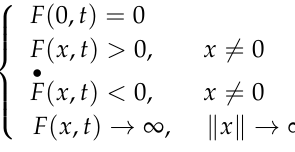
and i * are extracted cd cq and u * are the upper and lower and i ∗ are extracted dc1 dc2 cq cd and u ∗ are the upper and dc1 dc2